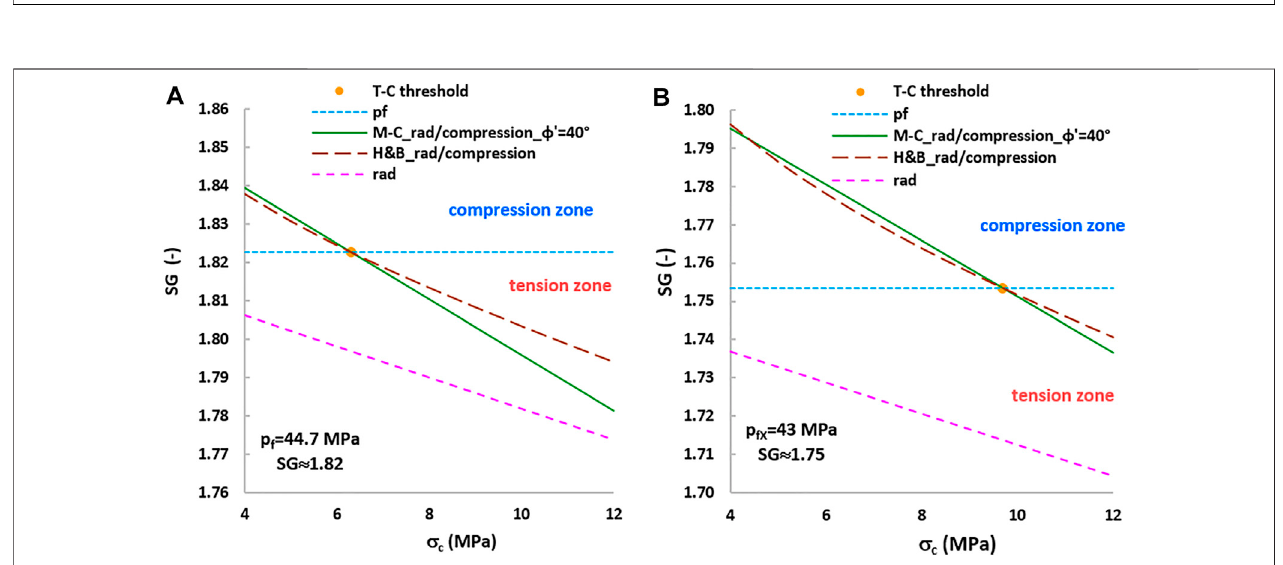
FIGURE 10 | Variation of the limit mud weight (SG) with the uniaxial compressive strength calculated with σ c = 4 – 12 MPa, ϕ ′ = 40 ° , m t = 10, and σ c / σ t ≈ 10. (A) Compressive failure and radial tensile failure with p f = 44.7 MPa. (B) Compressive failure and radial tensile failure with p f = 43 MPa.